Question: Looking at the figure, what chart type is it?
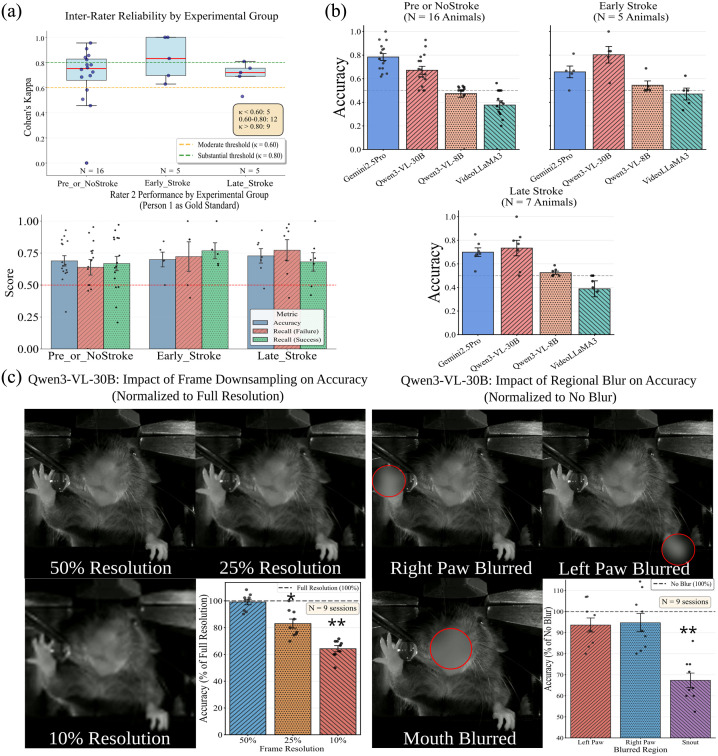
Answer: bar